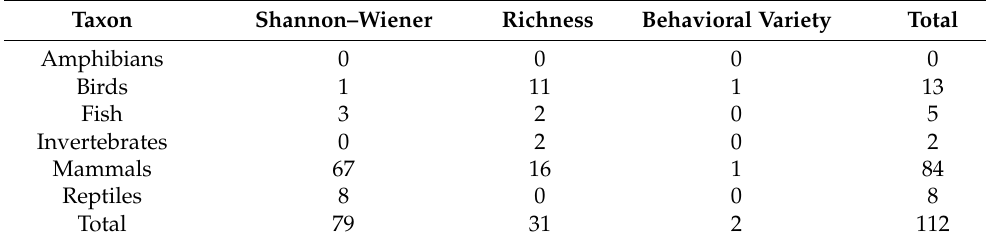
Table 1. Number of species studied using behavioral diversity measures in published studies. Taxon